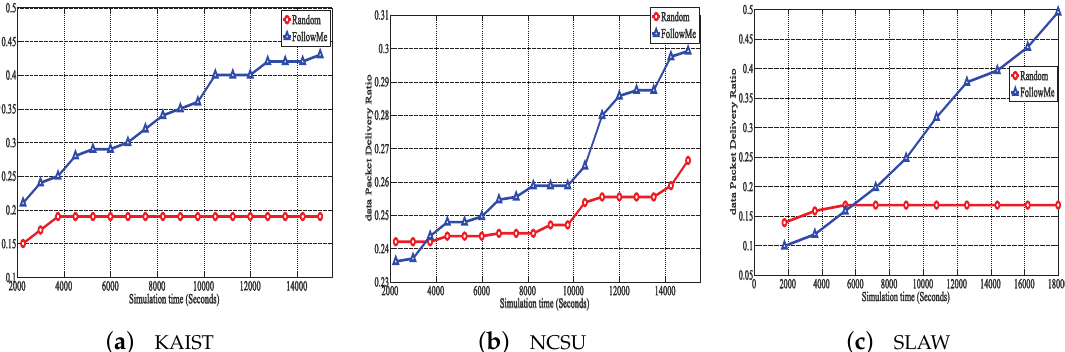
Figure 3. PDR of FollowME and Random within PRoPHET under three scenarios.